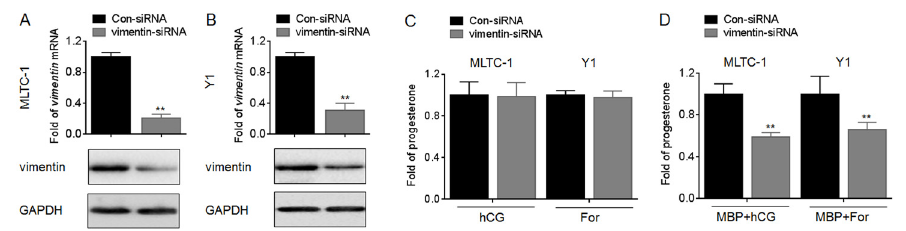
Fig 5. Effects of vimentin on the MBP-induced progesterone secretion. (A and B), MLTC-1 and Y1 cells were transfected by con-siRNA or vimentin-siRNA for 12 h, respectively, qRT-PCR (top) and Western blots (bottom) analysis of the expressions of vimentin mRNA and protein. (C and D), after MLTC-1 and Y1 cells were transfected by con-siRNA or vimentin-siRNA for 12 h, they were exposed to100 U/L hCG or 10 μ M forskolin in the absence or presence of 1000 nM MBP for 24 h, respectively. The secretion of progesterone was determined in triplicate. The amounts of progesterone measured in control cells were MLTC-1 (hCG): 8.32 ± 0.22 ng/ml, MLTC-1 (hCG+MBP): 10.10 ± 0.42 ng/ml, Y1 (For): 8.64 ± 0.33 ng/ml, and Y1 (For+MBP): 10.31 ± 0.21 ng/ml respectively. ** p < 0.01 compared with cells transfected by con-siRNA.